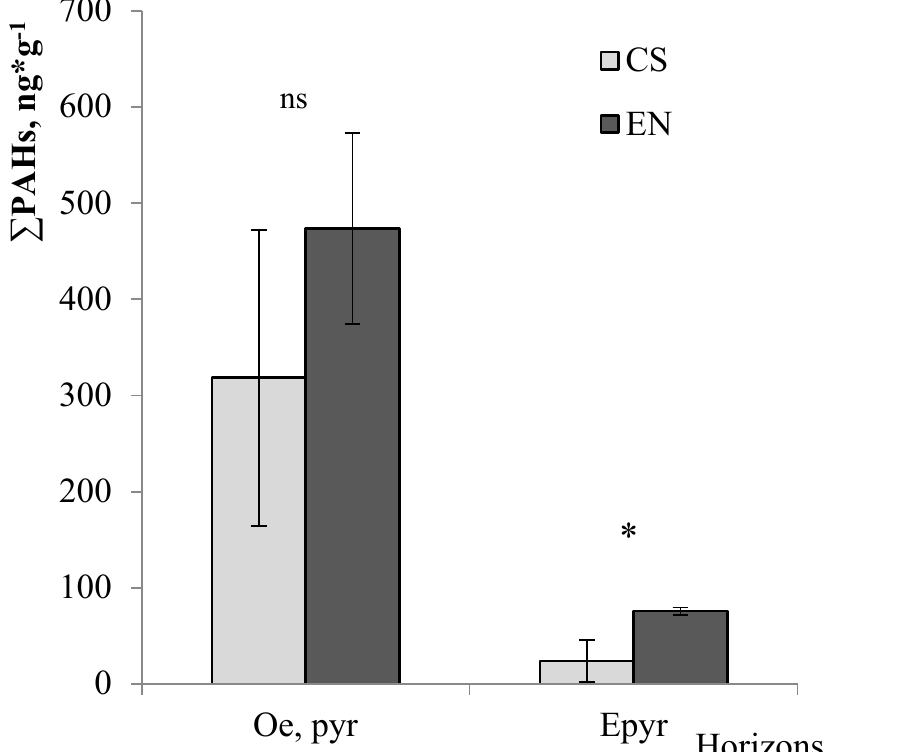
Figure 5. The total content of PAHs in the upper horizons of the studied soils ( n = 3, the error bars are the standard errors). Abbreviation: CS—Central Siberia, EN—European North. *—indicate significant differences between EN and CS, ns—differences between EN and CS are not significant at p < 0.05.